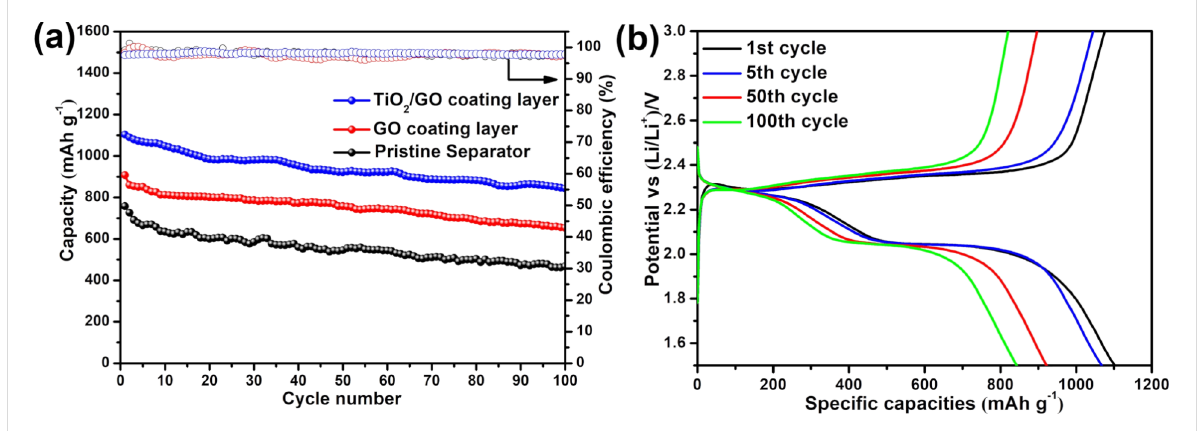
Figure 6: (a) Cyclic performance and coulombic efficiency of the Li/S batteries with pristine, GO-coated and TiO 2 /GO-coated separators at a c-rate of 0.2 C and (b) corresponding discharge–charge profiles of the Li/S batteries with a TiO 2 /GO-coated separator.